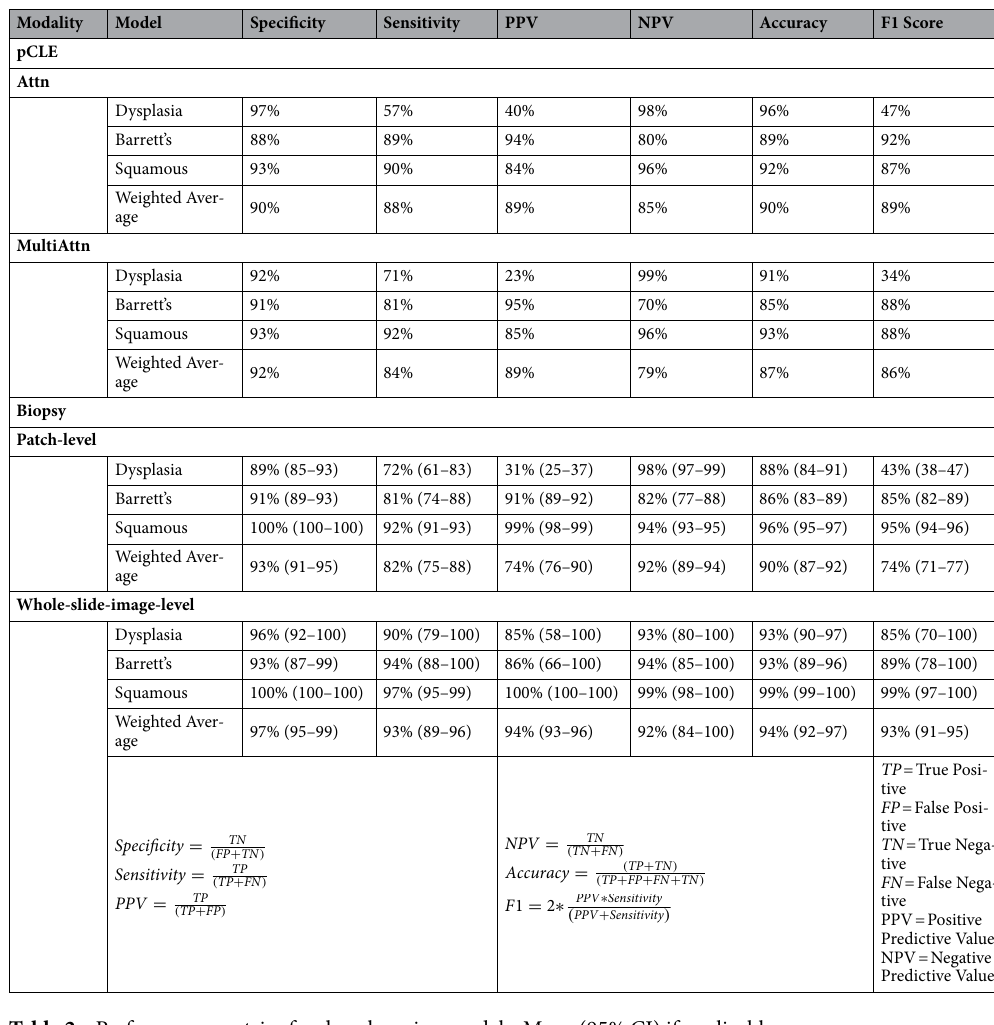
Table 2. Performance metrics for deep learning models, Mean (95% CI) if